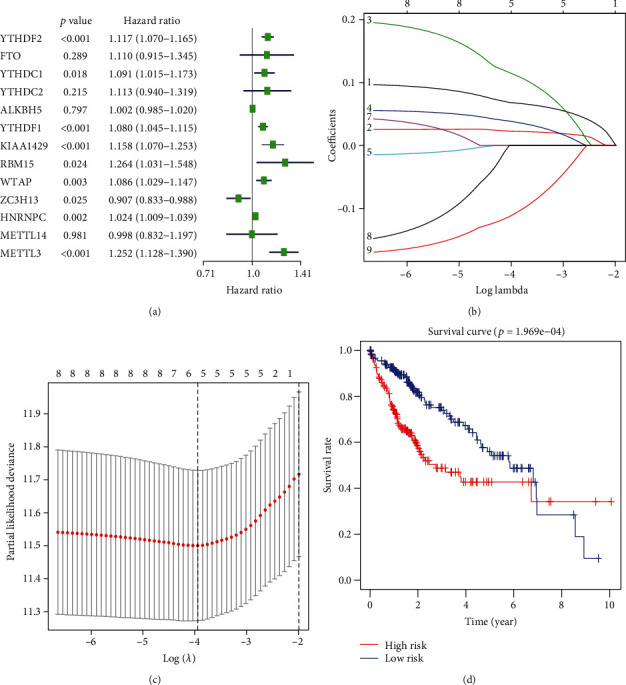
The effect of m6A RNA methylation regulators on the prognosis of hepatocellular carcinoma. (a) Cox univariate analysis of m6A RNA methylation regulators. (b, c) The coefficients calculated by multivariate Cox regression using LASSO are shown. (d) The Kaplan–Meier overall survival curves for patients in the TCGA datasets assigned to high- and low-risk groups based on the risk score.